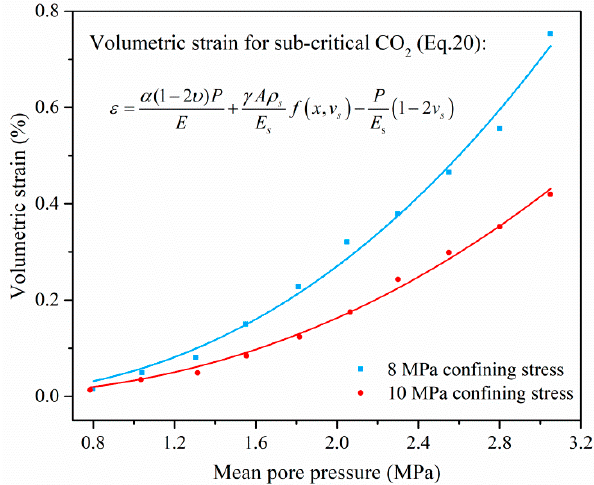
Figure 11. Variation of the volumetric strain versus the mean pore pressure (the mean of upstream and downstream pressures) of sub-critical CO 2 at 8 and 10 MPa confining pressures.